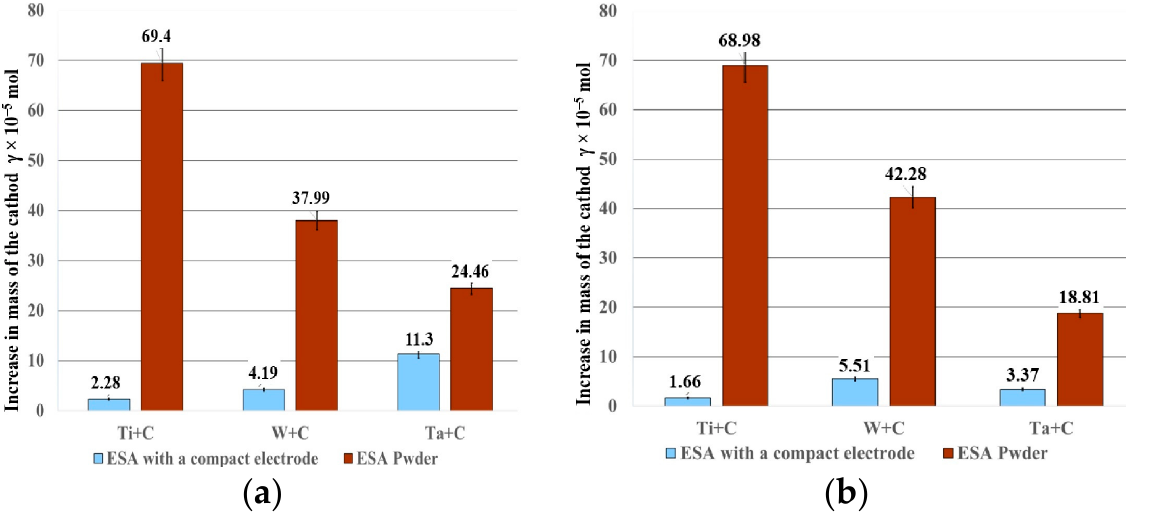
Figure 3. Histograms of cathode mass growth rates at the compact ESA and with additional powder supply when the mode of the discharge energy was Ер = 0.9 J: ( a ) cathode—C45, ( b ) cathode— commercial titanium BT1.